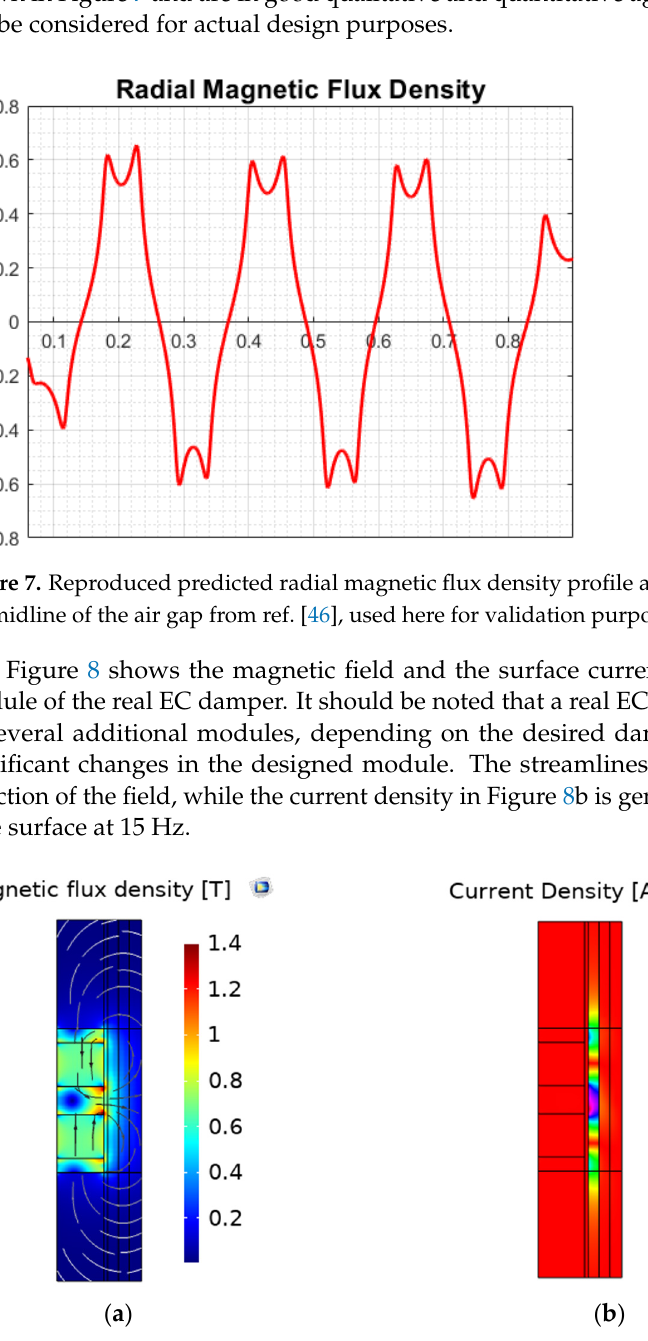
Figure 8. The reference (see Figure 1 for reference) EC damper model computed ( a ) magnetic; ( b ) current density fields across it at 15 Hz.